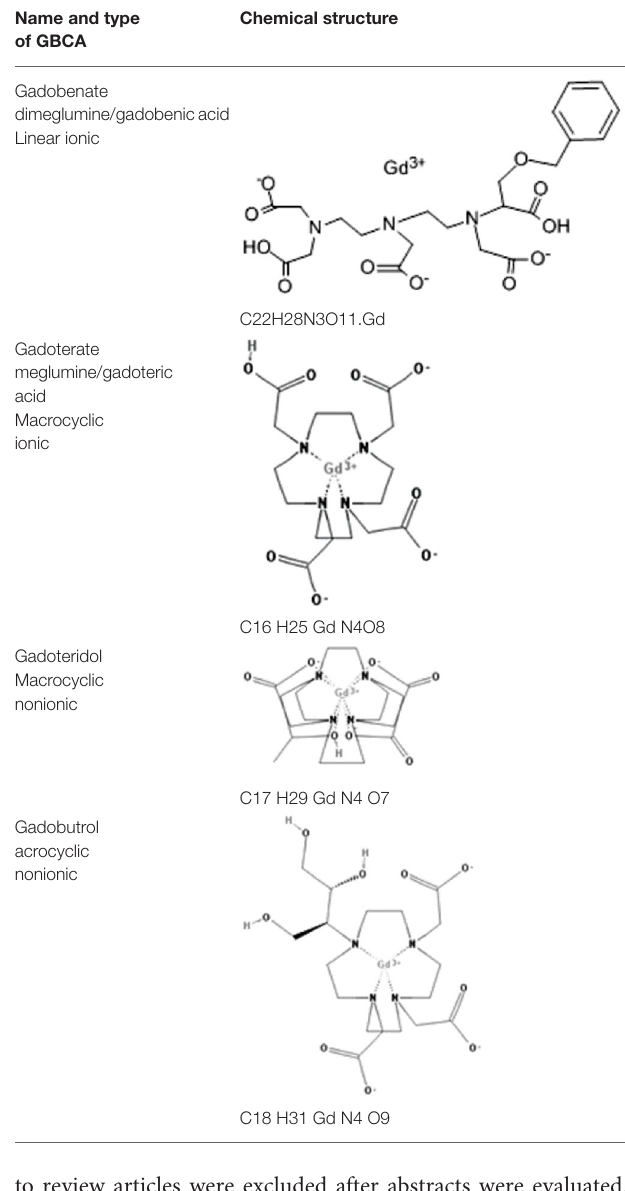
TABLE 1 | Available Gadolinium-Based Contrast Agents (GBCAs)and their chemical structures. Name and type of